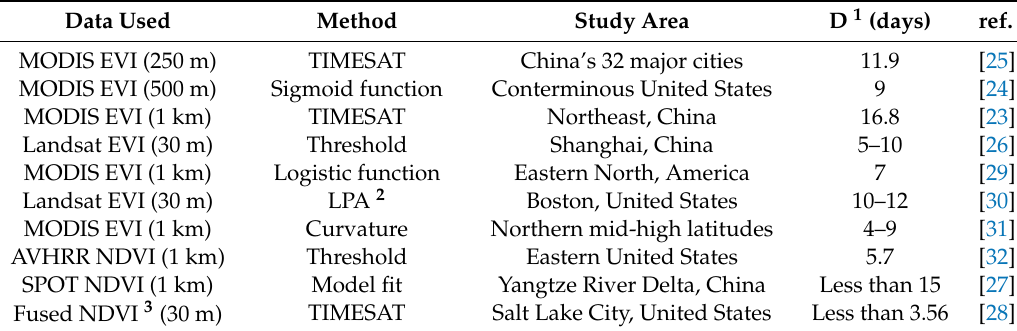
Table 1. Summary of previous studies of urbanization e ff ects on vegetation spring phenology using satellite